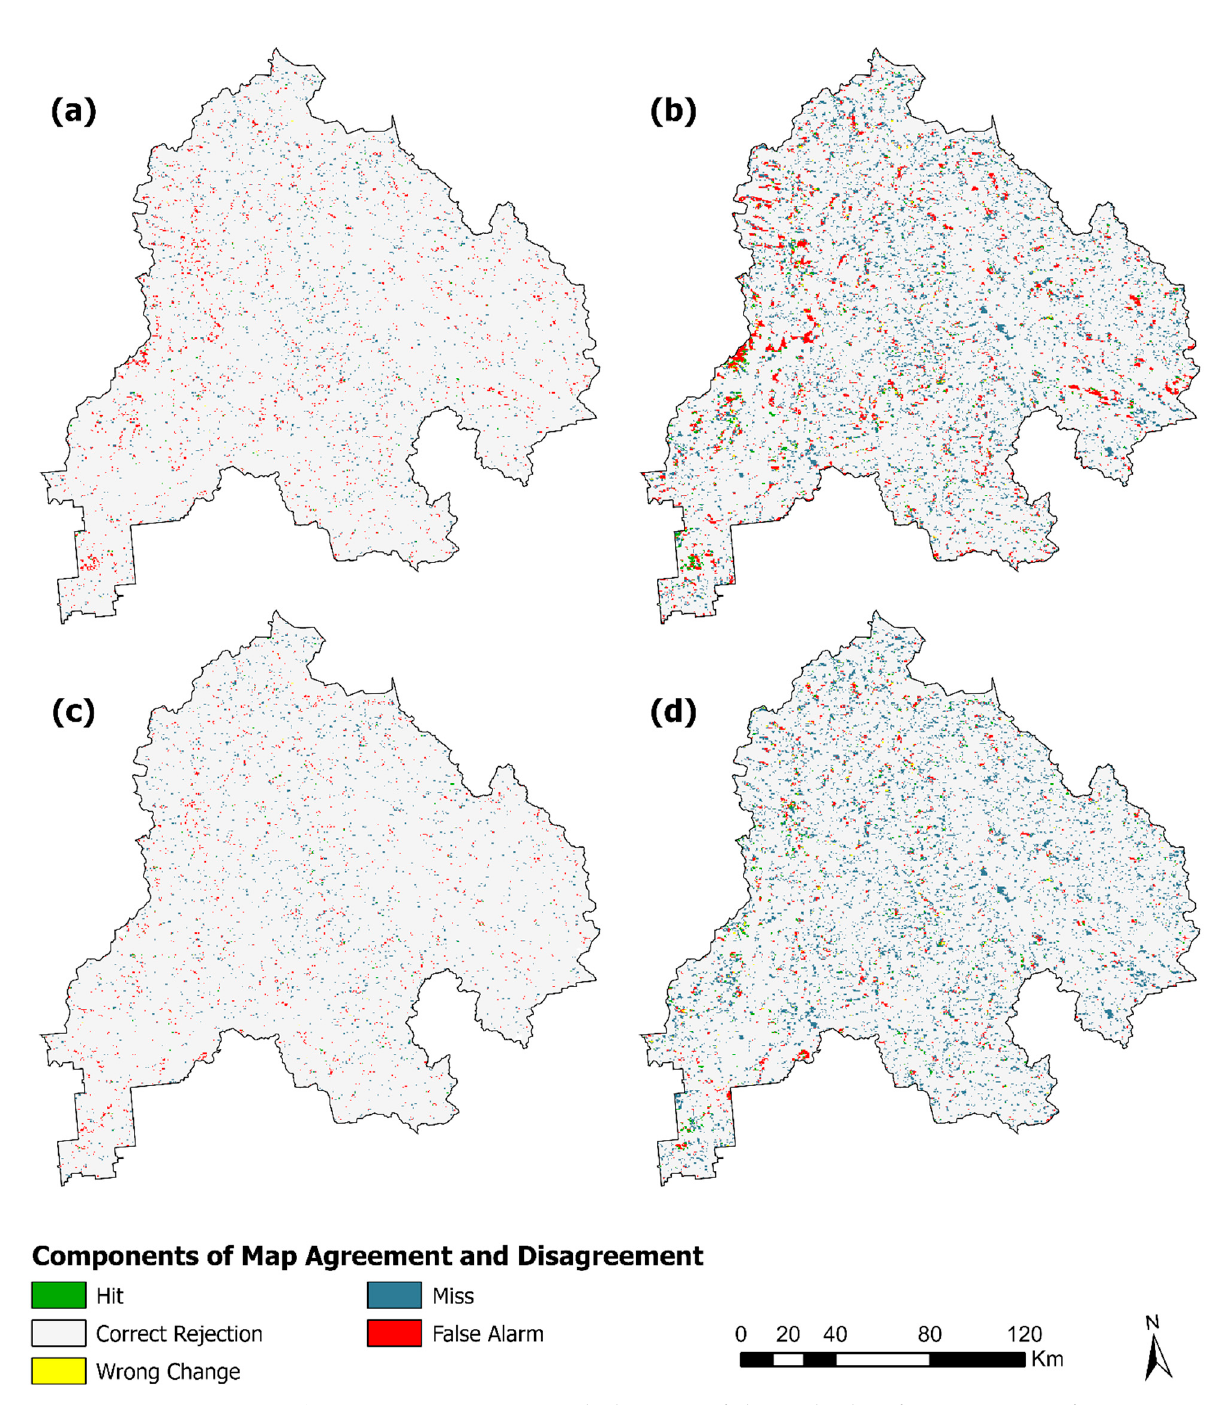
Figure 9. Maps representing the locations of obtained values for components of agreement and disagreement of forecasted LC with CNN-TCN STW for ( a ) 2016 and ( b ) 2020 and with ConvLSTM STW for ( c ) 2016 and ( d ) 2020.